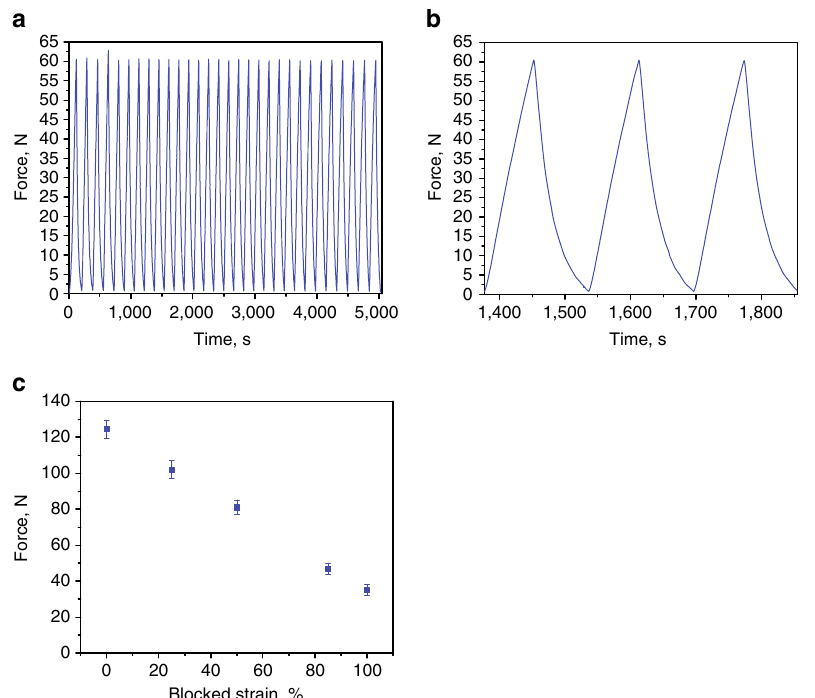
Fig. 3 Force – strain characteristics of the material (15 V, 1 A). a 30 following cycles of loading to 60 N (blocked force; cylindrical specimen; diameter 15.1 mm, length 40 mm; weight 6 g). b Detailed view of three cycles in a . c Blocked force at various elongations for constrained cylindrical actuation; error bar relates to s.d. Specimen diameter 11.1 mm, length 25 mm; weight 2 g. Note that the actuation depends on heating and cooling